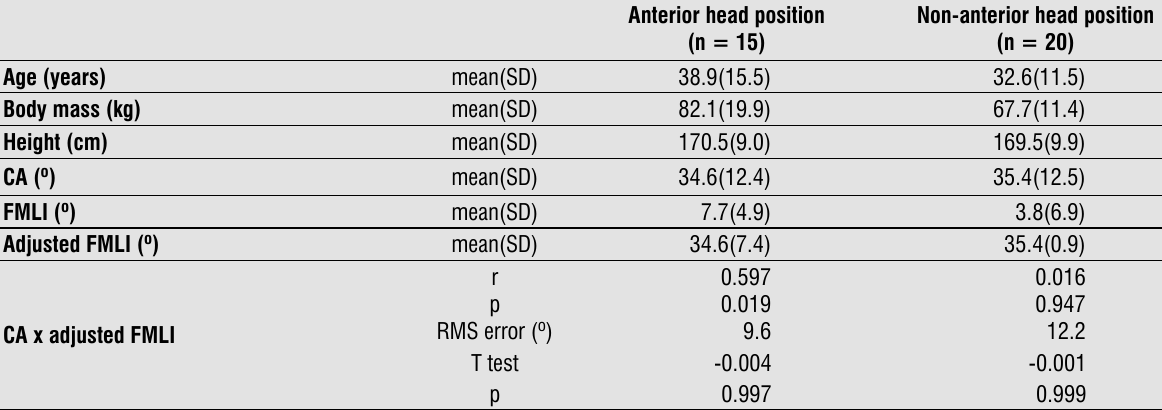
Table 2 – TFMLI validation: mean and standard deviation (SD) of the anthropometric characteristics, Cobb angle (CA), frontal-mental line inclination (FMLI) and frontal-mental line inclination adjusted according to CA (adjusted FMLI); Pearson’s Product-Moment Correlation Test (r) and RMS error for sample divided into groups: group with anterior head position and group with non-anterior head